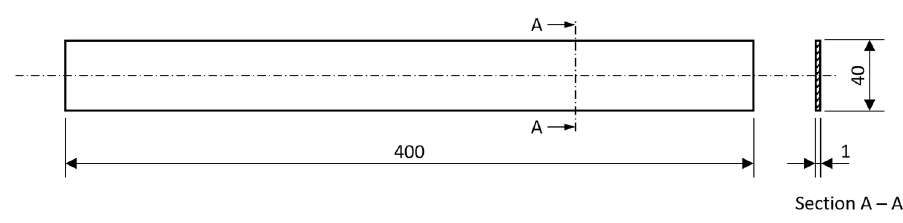
Figure 20. Specimen for four point bending tests (all dimensions in mm).